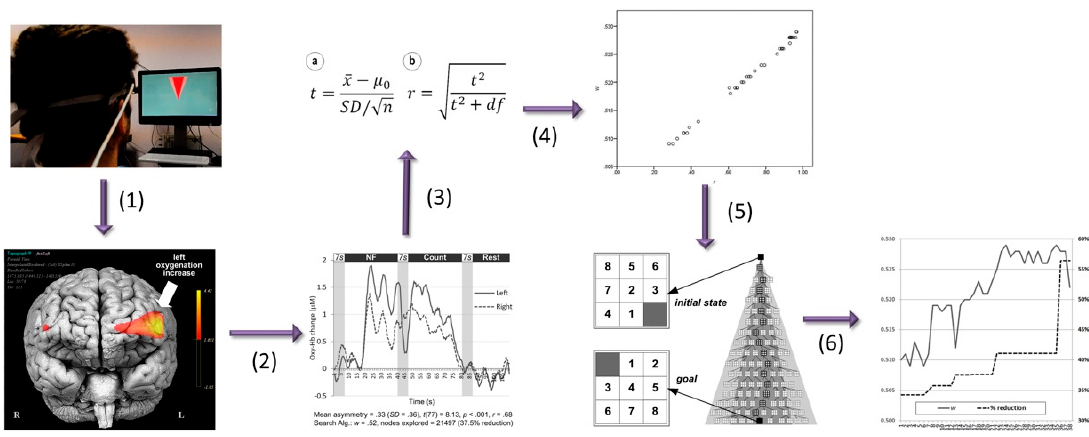
Figure 5. Brain–computer interfaces (BCI) interfacing to heuristic search on the 8-puzzle. The user’s motivational dimension is obtained through fNIRS measurement of PFC asymmetry ( 1 ). The level of change from the baseline, which is taken to measure approach, is determined with real-time statistical testing ( 2 , 3 ). It is mapped linearly onto the WA* weighting parameter using the effect size to determine the level of heuristic modification ( 4 ). The change in weighting parameter for WA* is applied during the search ( 5 ), which results in search space reduction and computation speed-up ( 6 ). Note the abstract representation of the search space as a two-dimensional (2D) beam ( 1 ), which serves as a visual feedback for fNIRS NF (adapted from [71]).